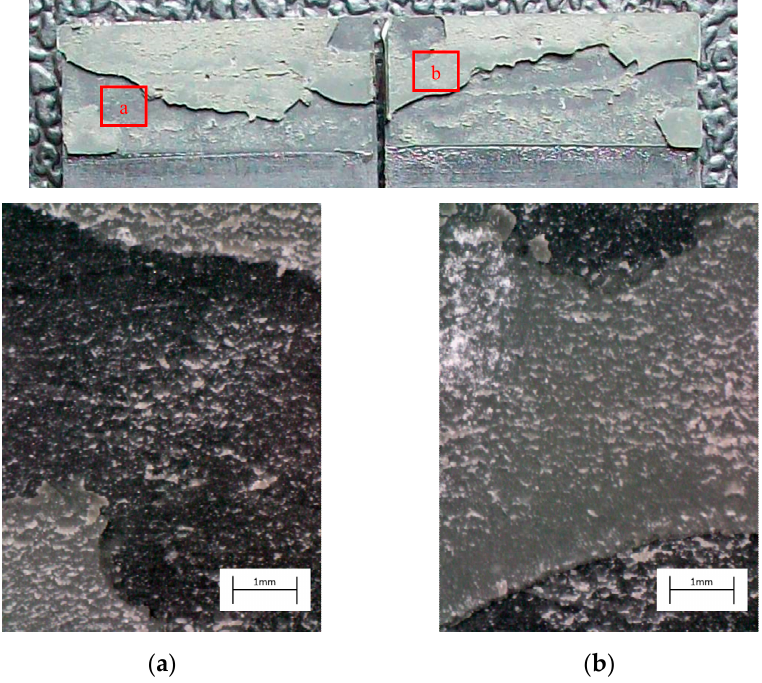
Figure 21. Fracture surface of a specimen pretreated with abrasion + APPT with D = 5 mm and v = 100 mm/s and subjected to fatigue test, with magnified details ( a ) and ( b ) acquired by microscope.